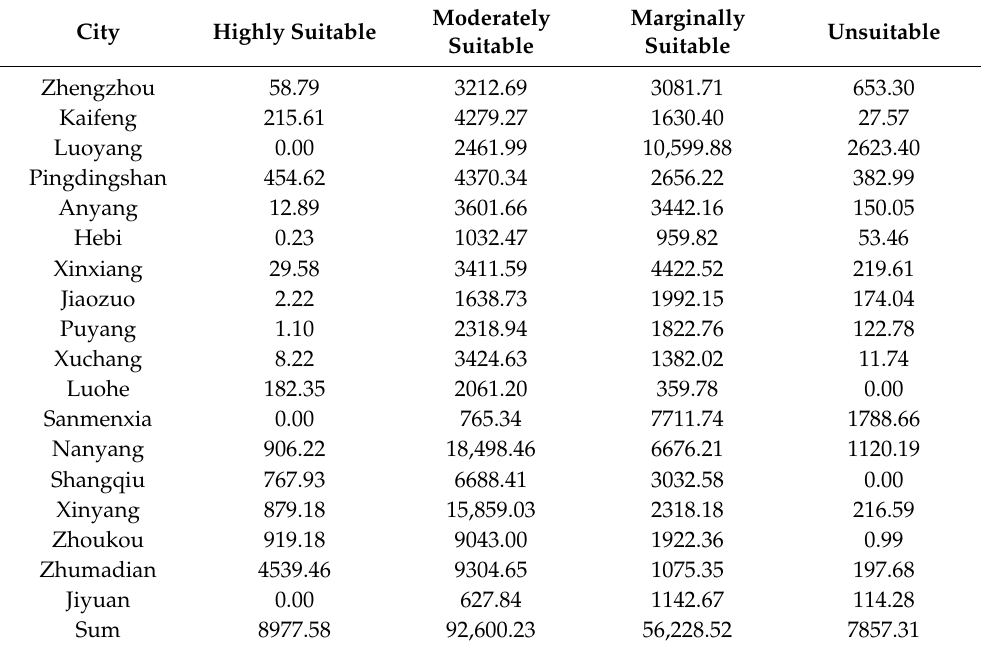
Figure 8. Spatial distribution of cultivability evaluation results in Henan province. Table 3. Statistical table of cultivability evaluation area of cities in Henan province (km 2 ).